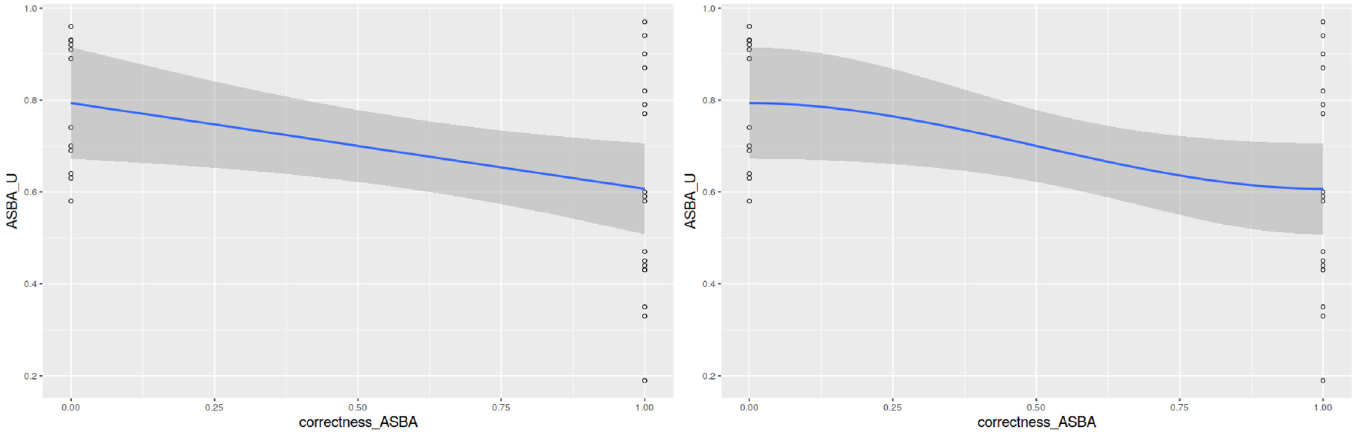
Fig 6. Relationship between ASBA correctness and uncertainy of ASBA using linear regression (left subfigure) and LOESS regression (right subfigure). The correctness increases as uncertainty decreases.